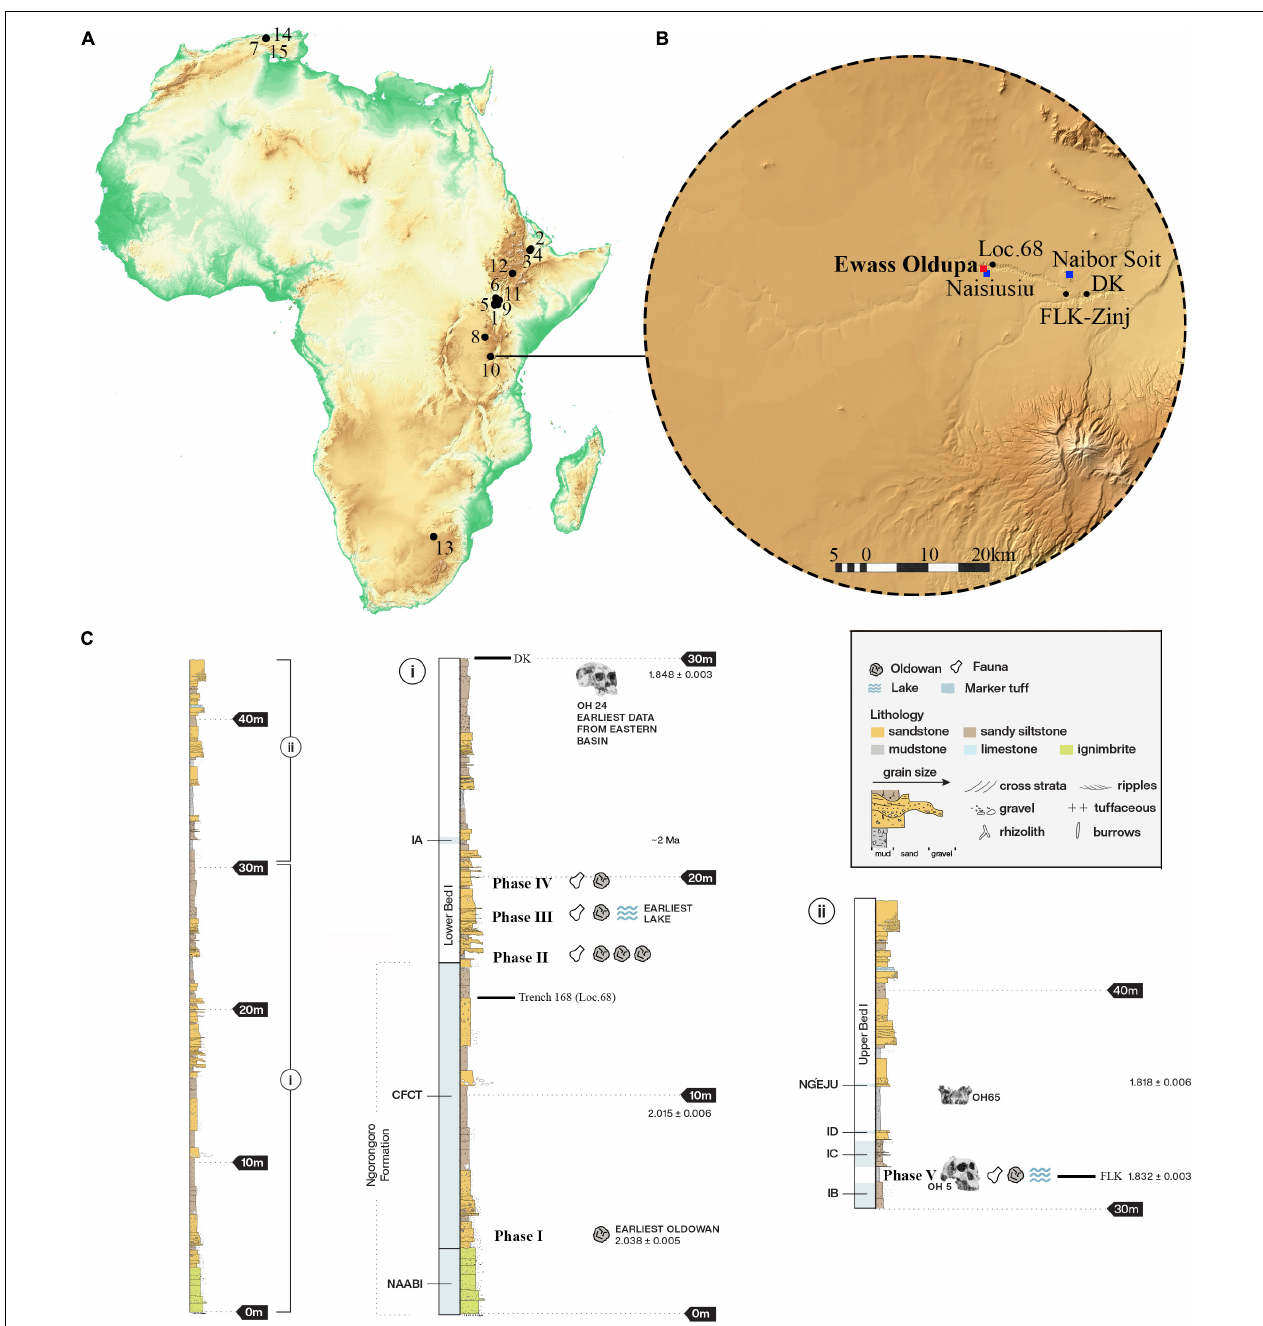
FIGURE 1 | (A) Map of Early Oldowan African sites: 1, Lomekwi; 2, Bokol Dora; 3, Gona; 4, Hadar (AL666); 5, Lokalalei; 6, Omo; 7, Ain Boucherit; 8, Kanjera South; 9, Koobi Fora; 10, Oldupai Gorge; 11, Fejej; 12, Melka Kunture; 13, Sterkfontein; 14, Ain Hanech; 15, El Kherba. (B) Detail map on Oldupai Gorge and the location of Ewass Oldupa in relation with DK, FLK, Loc. 68, Naibor Soit and Nasiusiu. (C) Stratigraphic section from Ewass Oldupa, subdivided into two segments: Lower Bed I (i) and Upper Bed I (ii). See Mercader et al. (2021) for detailed descriptions. Maps modified from Tinted Hillshade using ESRI ArcGIS Desktop 10.5.1 (https://desktop.arcgis.com) and Images ServicesWorldElevation/Terrain Server Tinted Hillside Airbus, USGS, NGA, NASA, CGIAR, NCEAS, NLS, OS, NMA, Geodatastyrelsen, GSA, GSI and the GIS user community (CC BY-SA 4.0; https://creativecommons.org/licenses/by/4.0/).